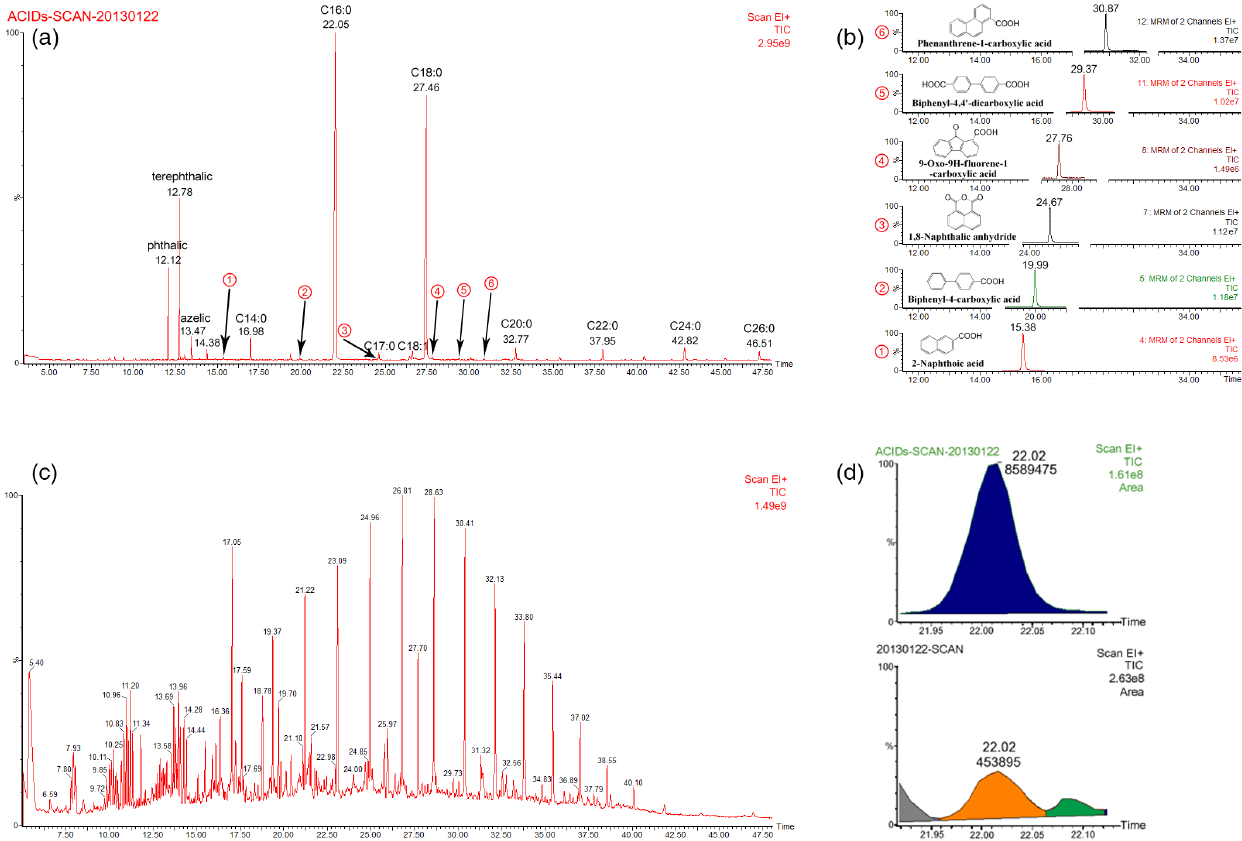
Figure 2. Chromatograms of the organic compounds of the PM 2 . 5 sample collected on 22 January 2013 in Beijing after pretreatment using an NH 2 -SPE cartridge. (a) GC-MS chromatograms of organic acids in SPE eluate. (b) GC-MS-MS chromatograms of PAH acids in SPE eluate. (c) GC-MS chromatogram of compounds from combined effluate and washing solution. (d) The integrated areas of palmitic acid in the elute (top) and methyl hexadecanoate in the combined solution